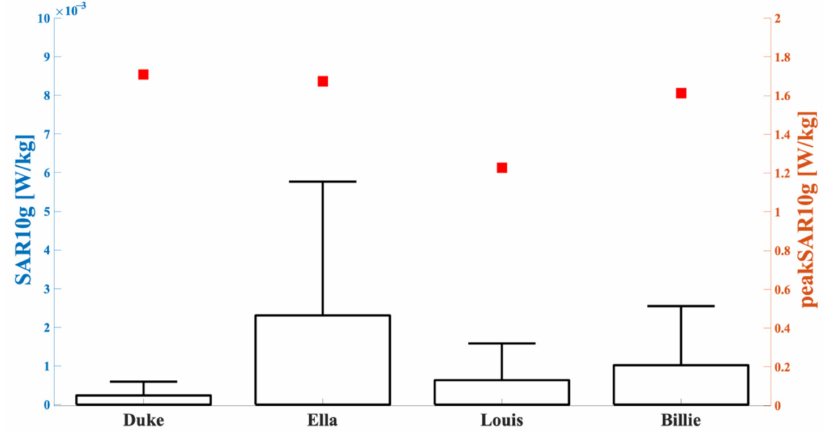
Figure 6. SAR 10g (left y -axis, boxplot) and peak SAR 10g (right y -axis, square symbols) in the tissues included in the cubical box relative to the analyzed simulated human model. The bottom and top edges of the boxes are the 25th and 75th percentiles. The lower whisker extends to the minimum values, while the upper whisker extends to 1.5 times the height of the box.